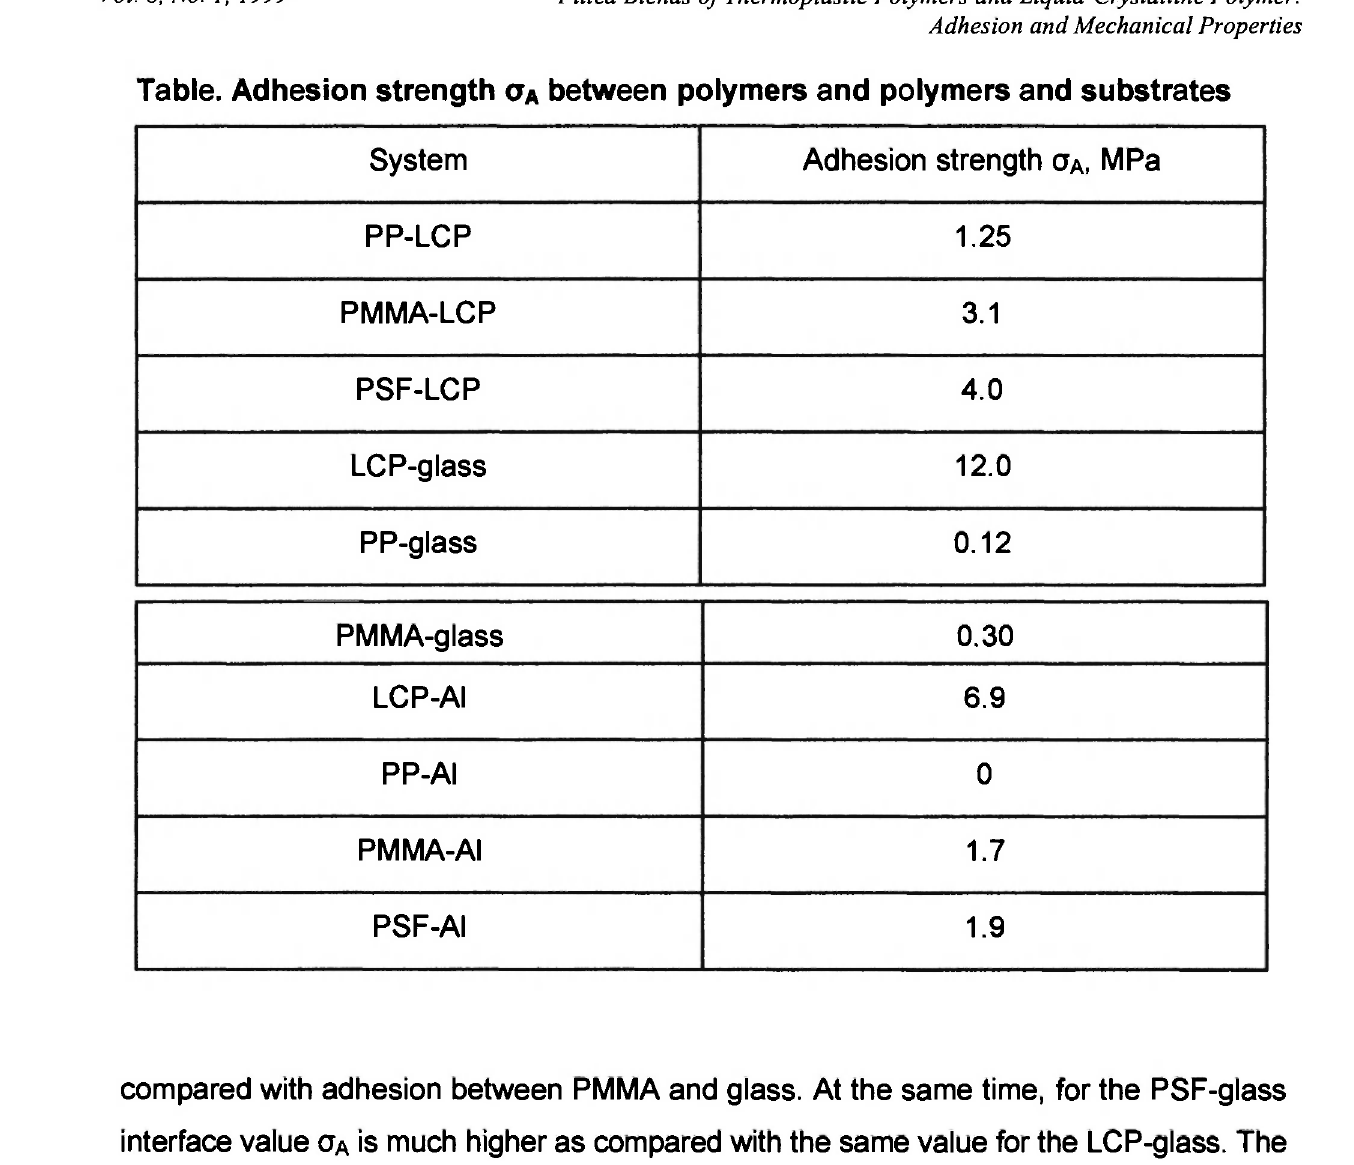
Table. Adhesion strength QA between polymers and polymers and